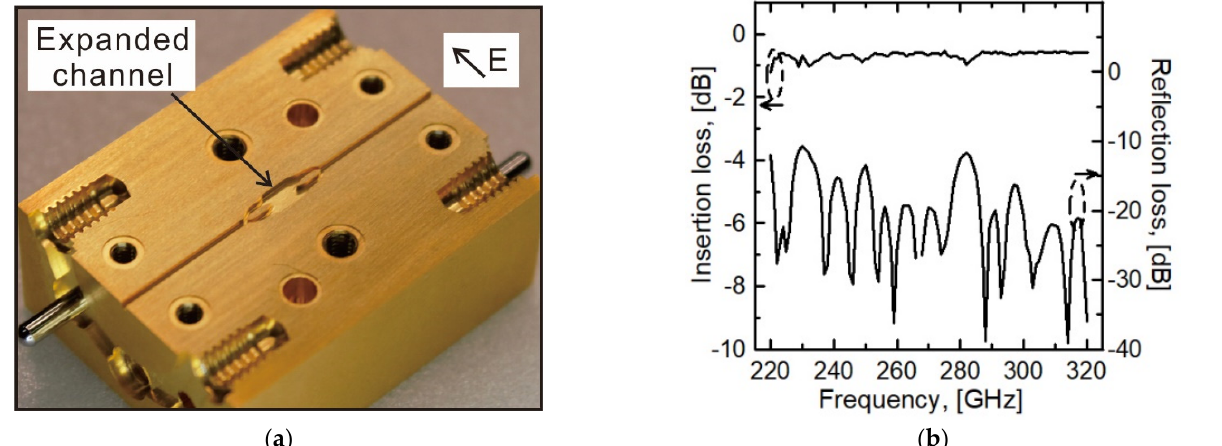
Figure 4. Empty array module test. ( a ) Photograph showing the bottom half of the empty module; ( b ) measured insertion and reflection losses.